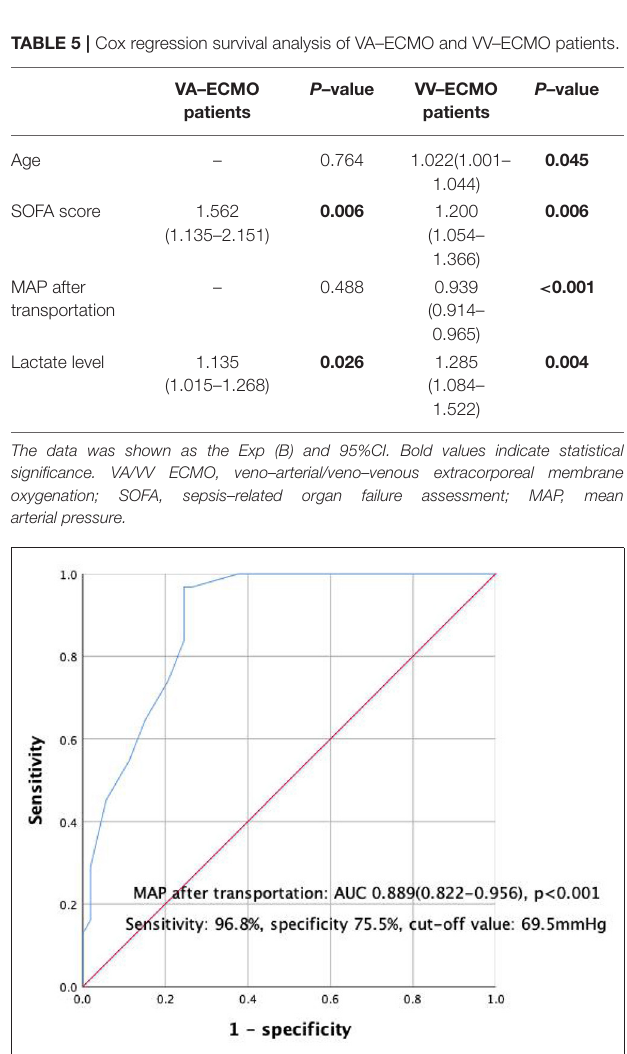
FIGURE 4 | ROC curve of VV-ECMO patients’ MAP (mean arterial